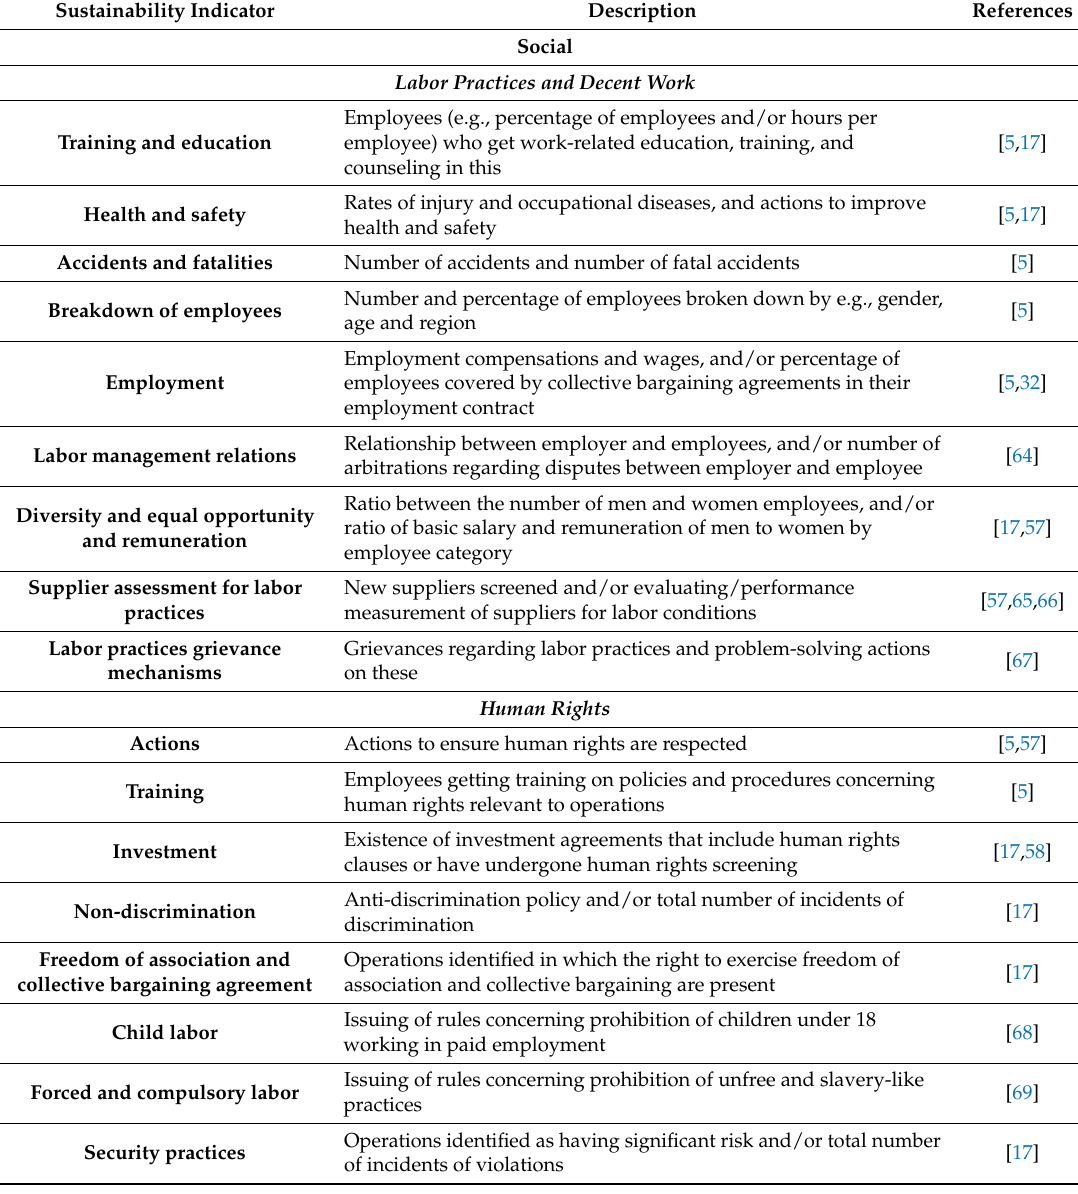
Table A1. Sustainability